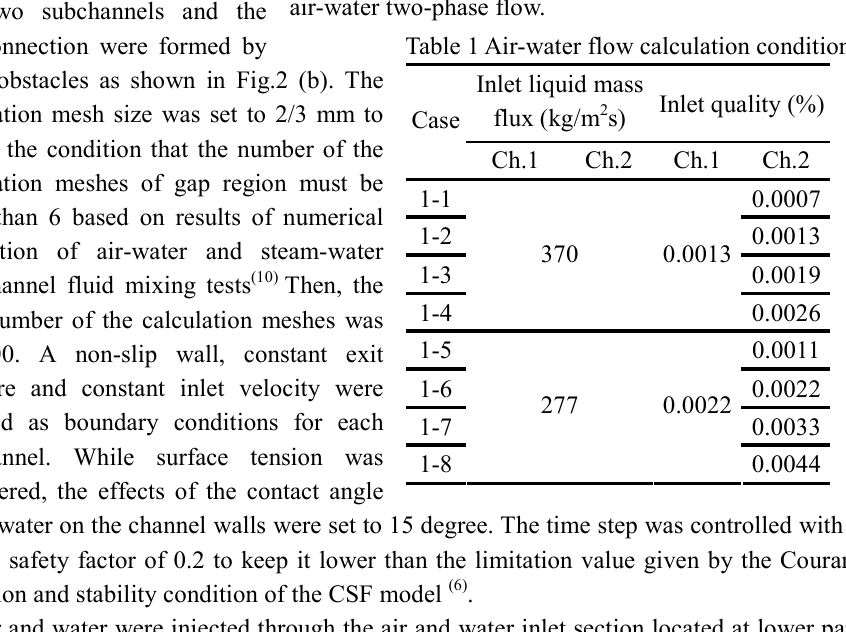
Fig.2 Dimensions of calculated test channel and calculation meshes in channel cross section for air-water two-phase